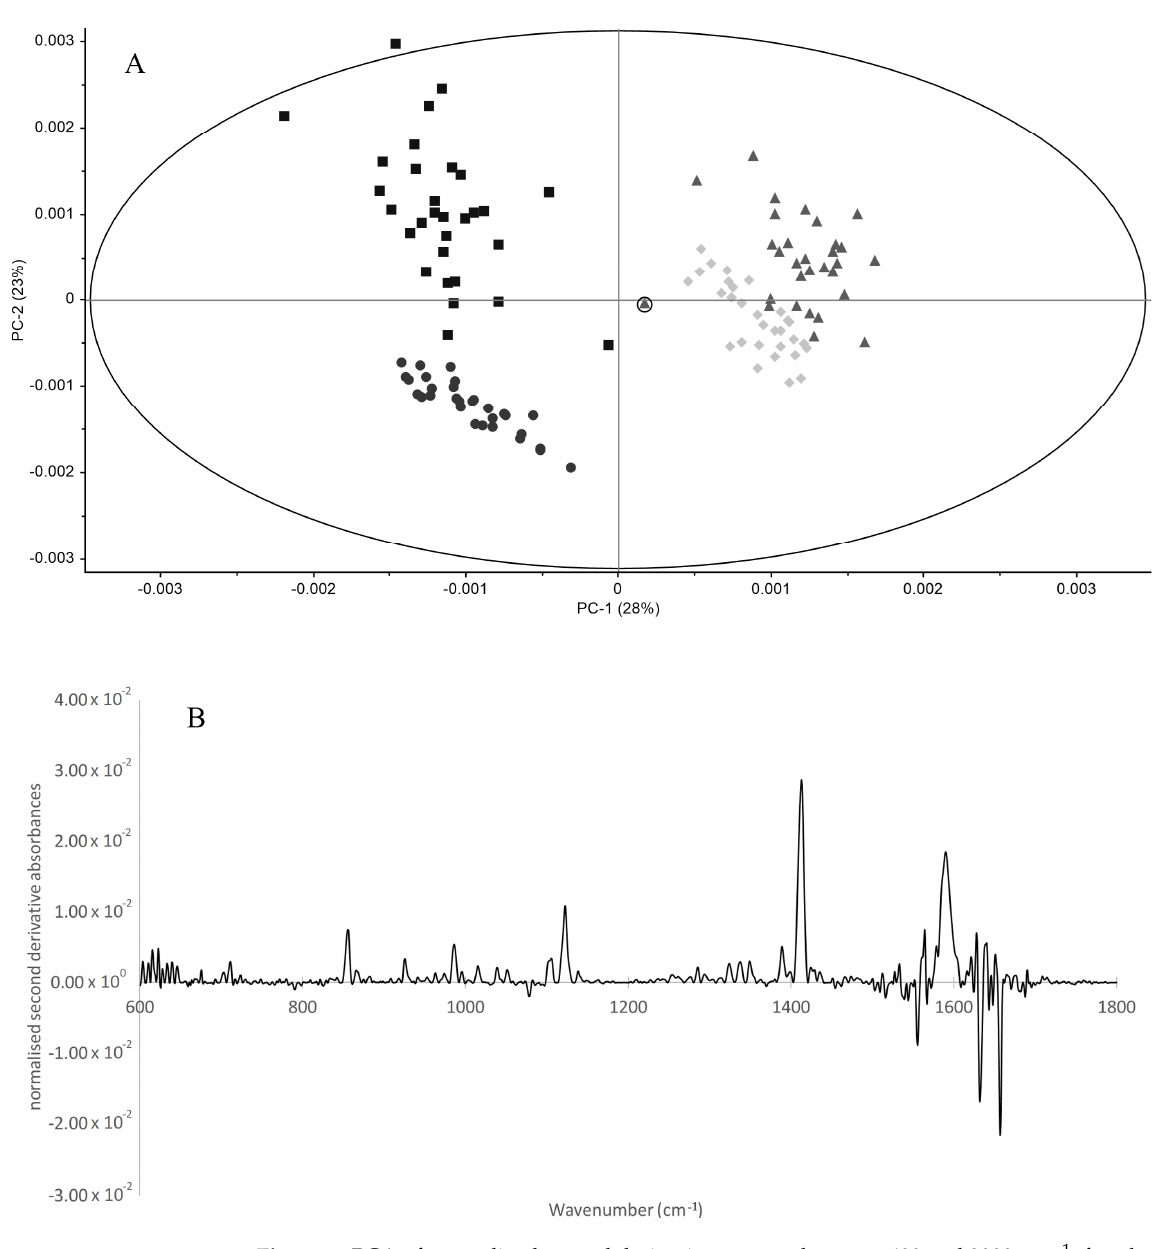
Figure 4. PCA of normalized second derivative spectra, between 600 and 3000 cm − 1 , for plasma at T0 (squares) and T90 (circles), and serum samples at T0 (triangles) and T90 (diamond), with Hotelling’s ellipse at 1% significance ( A ); and the corresponding PC1 loading vector ( B ). The sample in “A” marked as a triangle with an outside circle represents the unique sample misclassified in the HCA (corresponding to a serum sample at T0 from volunteer 10).